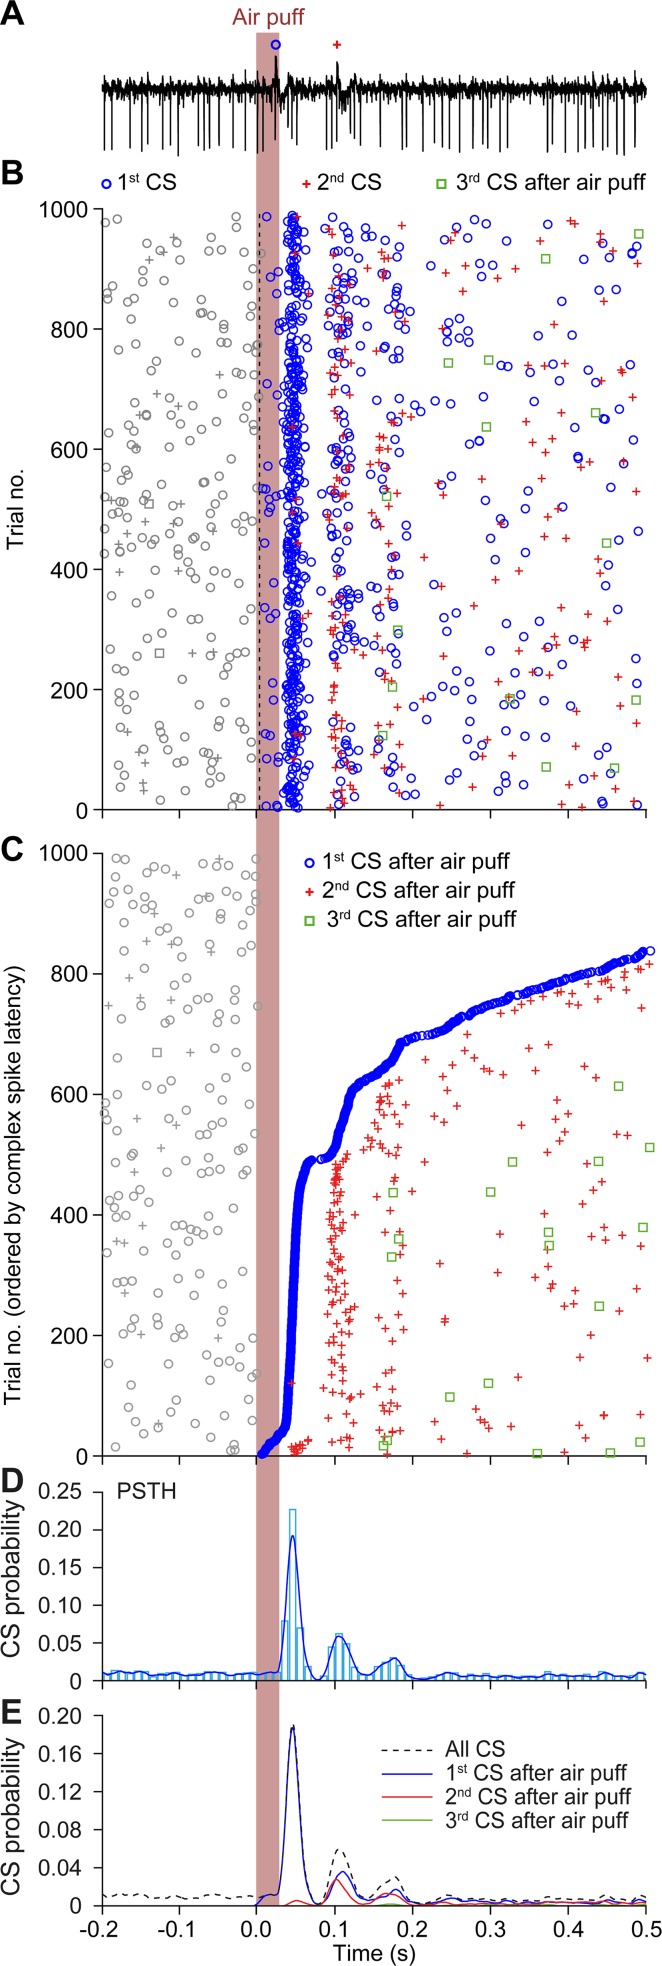
Stability of rhythmic complex spike activity in a Purkinje cell of an awake mouse.(A) Rhythmic complex spike (CS) responses to whisker pad air puff stimulation in a representative Purkinje cell recorded in crus 1. Representative trial from an extracellular recording with a stimulation frequency of 0.5 Hz. In this and subsequent panels, CSs are marked with symbols representing their order of occurrence following the stimulus within each trial. (B) Rhythmic behavior of CSs becomes apparent in a raster plot. Note that the rhythmicity is relatively stable over the 1,000 trials. (C) Same as in B but with trials sorted by the latency to first CS. This reveals that the occurrence of CSs is largely organized in temporal windows of opportunity. Some CSs appear in later response peaks without prior firing in earlier windows of opportunity. As the CS response may appear in the early and/or in the late window, this is suggestive of a readout from an underlying oscillatory process. This phase dependence would not appear if it would be solely due to a reset followed by transient oscillation evoked exclusively in the spiking cell. If CS firing during the later peaks was predicated on an earlier phase-aligned CS, then later CS responses would have no reason to align with the second or the third peaks of the PSTH (in D and E). (D) PSTH of CS firing. The bin-width is 10 ms and the blue line shows the convolved histogram with a 5 ms kernel. (E) The same PSTH as in D, but now the probabilities of the first, second and third CS after the stimulus shown separately, highlighting the occurrence of windows of opportunity for stimulus triggered CSs.